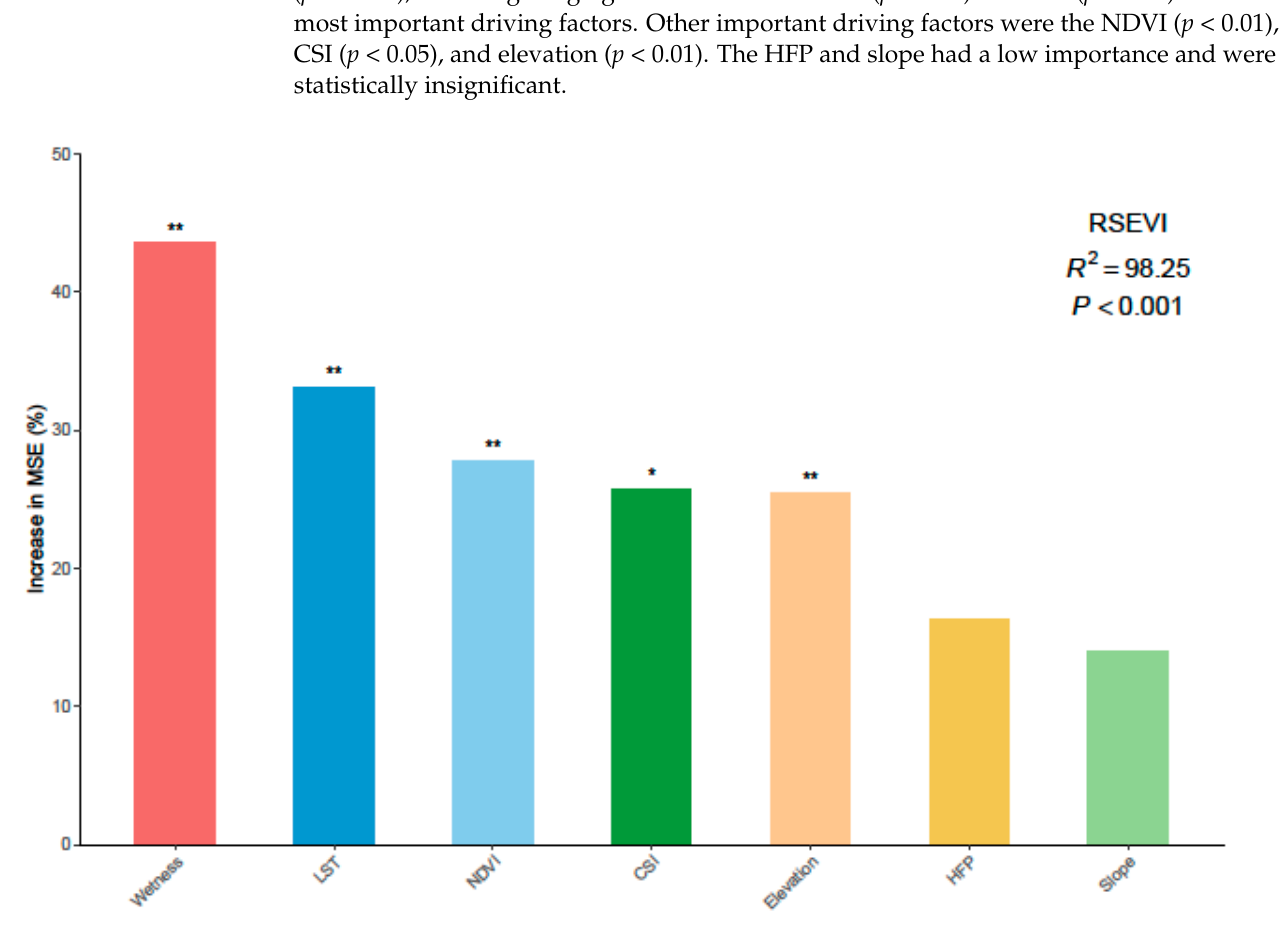
Figure 4. The standard deviation ellipse and its gravity center of the spatially distributed remote sensing ecological vulnerability index on the Qinghai-Tibet Plateau from 2000 to 2018.